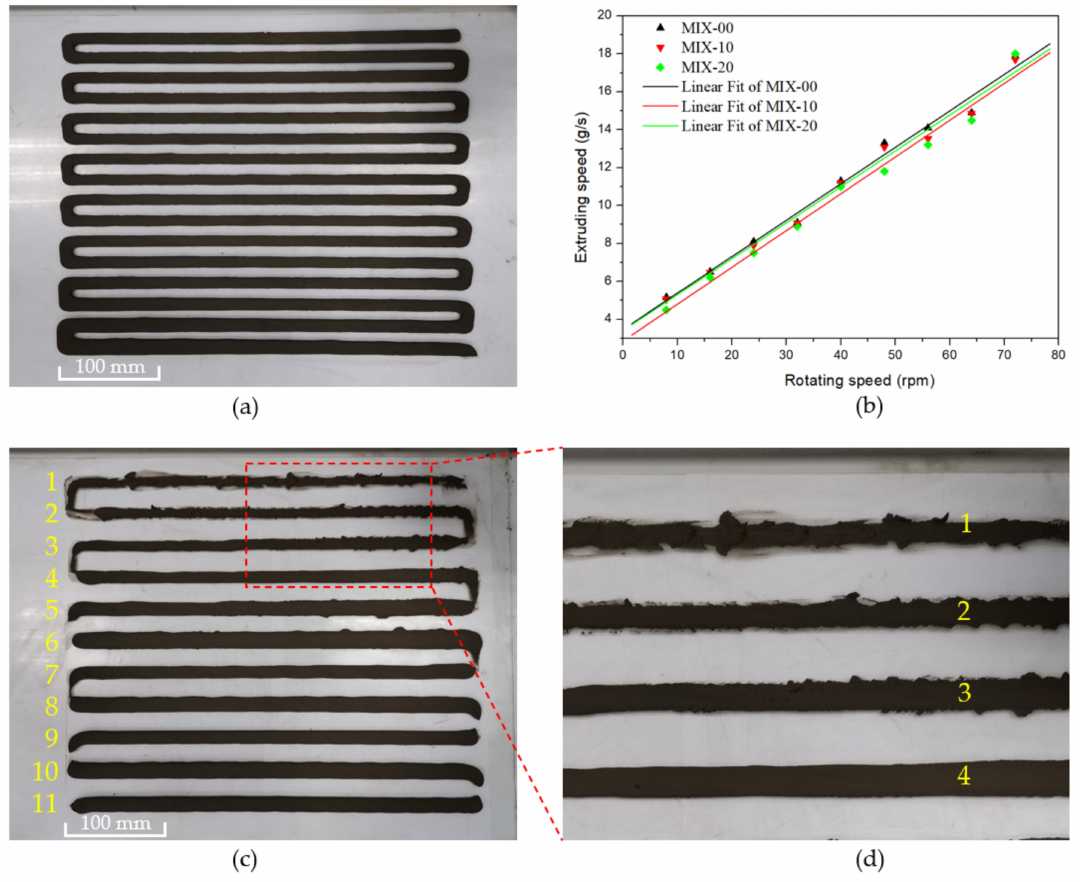
Figure 8. Tests and results of extrudability and layout ability: ( a ) extrudability test, ( b ) graphed data of the rotating speed vs. extruding speed, ( c ) layout ability test, and ( d ) high-definition image of the layout ability